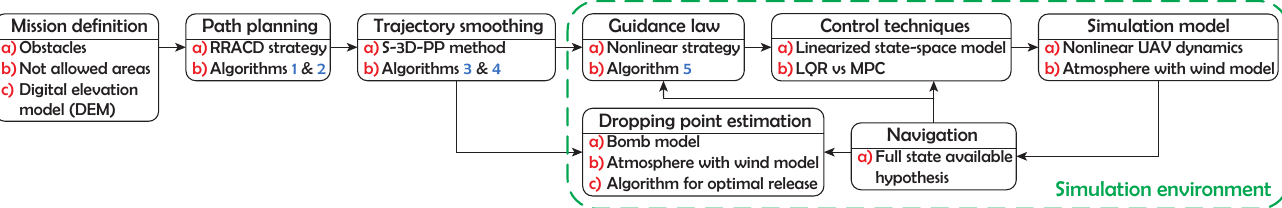
Figure 1. Diagram of the technical procedure conducted in the